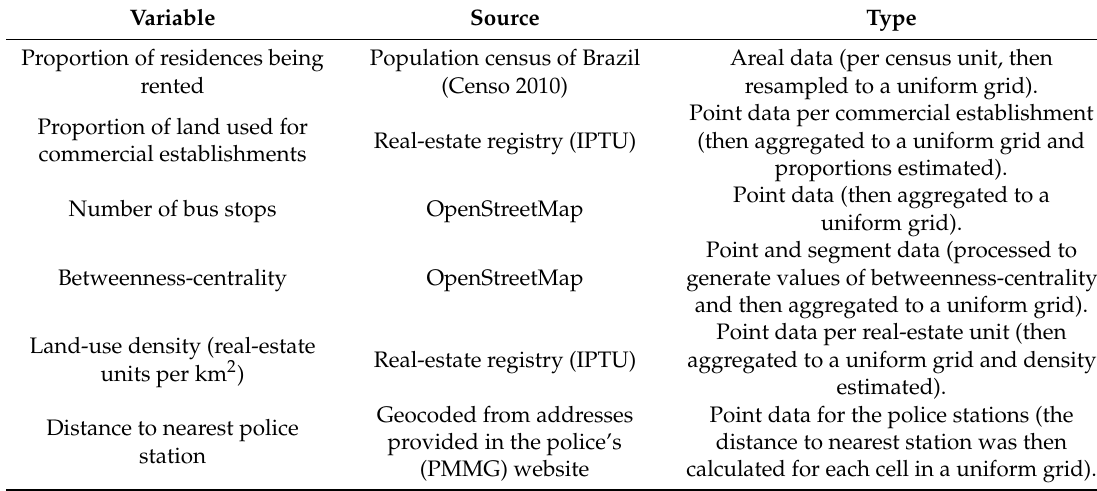
Table 3. Source and data type for the control variables used.